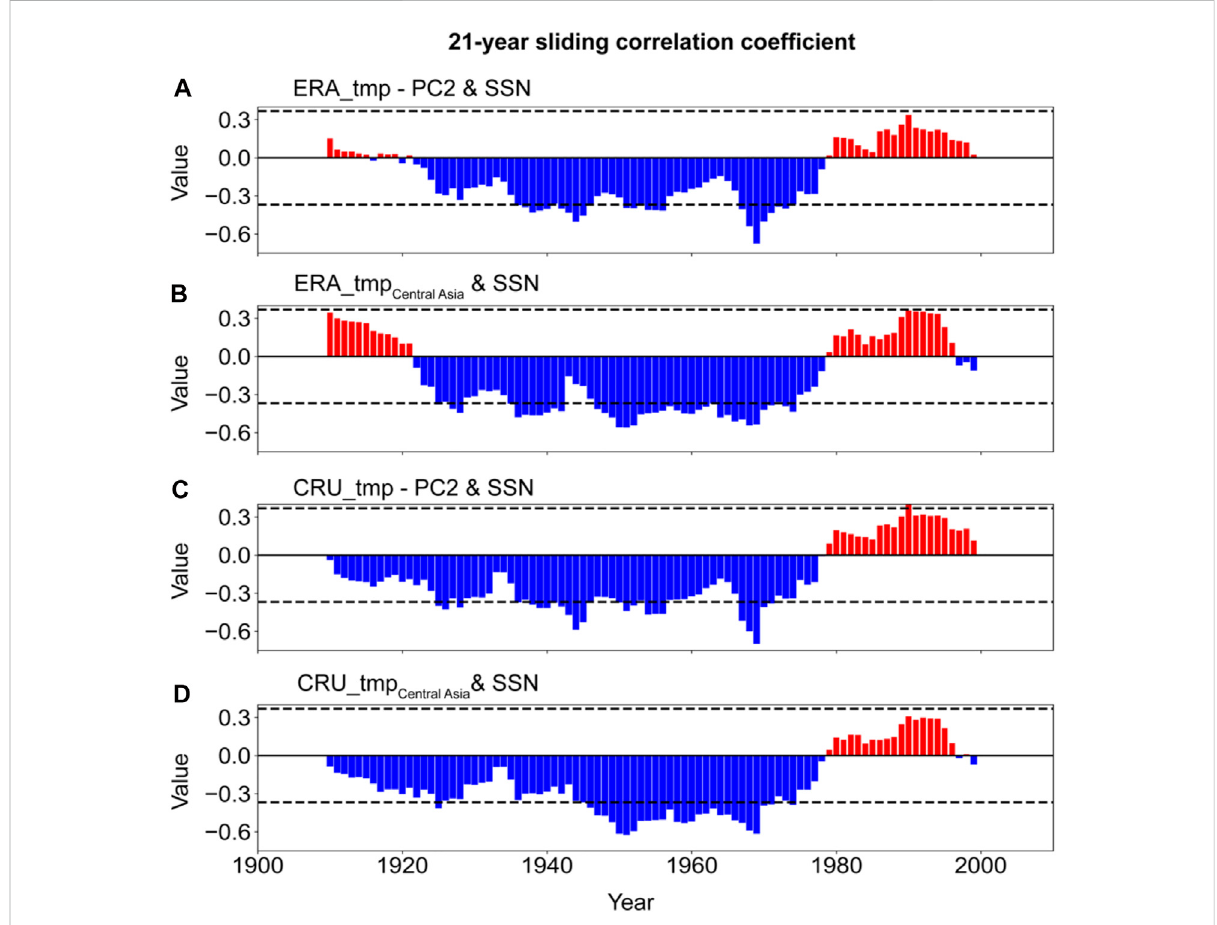
FIGURE 10 The 21-year sliding correlation coef fi cient between SSN and the time series of PC2 (A – C) and the temperature of Central Asia (B – D) during 1901 – 2010. The values of dashed lines are ± 0.369, which represents the 90% con fi dence